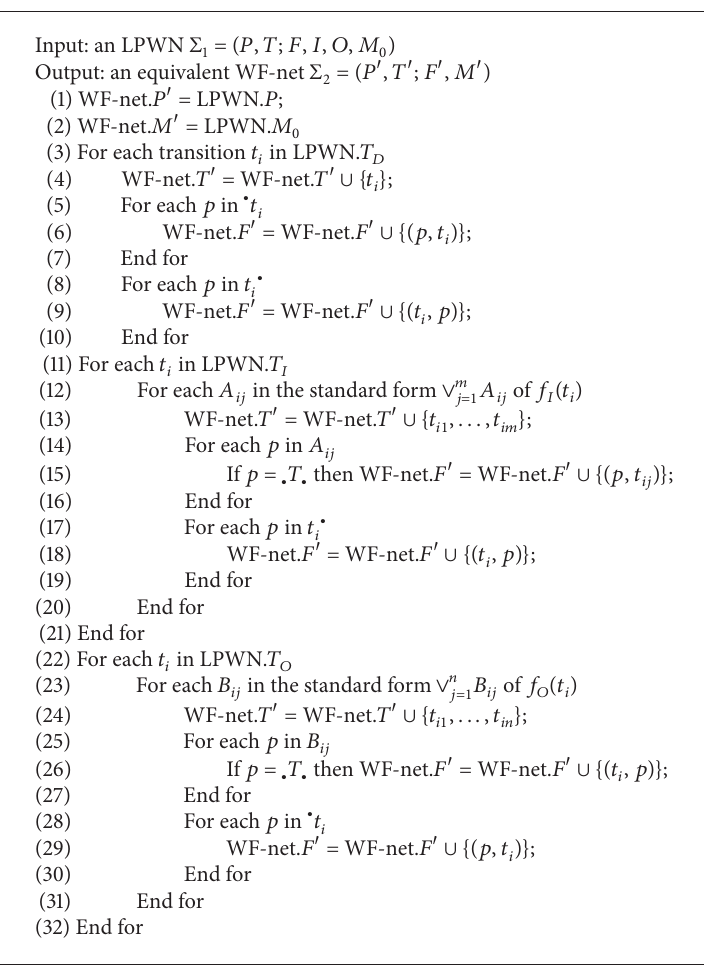
Algorithm 1: Transforming an LPWN into an equivalent WF-net.